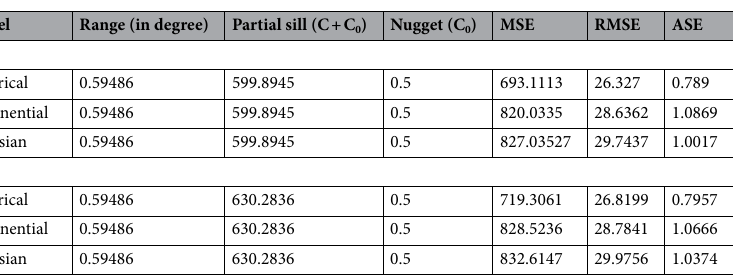
Table 2. Cross-validation results of semivariogram experimental models on RBD disease severity during 2018 and 2019. MSE mean square error, RMSE root mean square standard error, ASE average standard error.